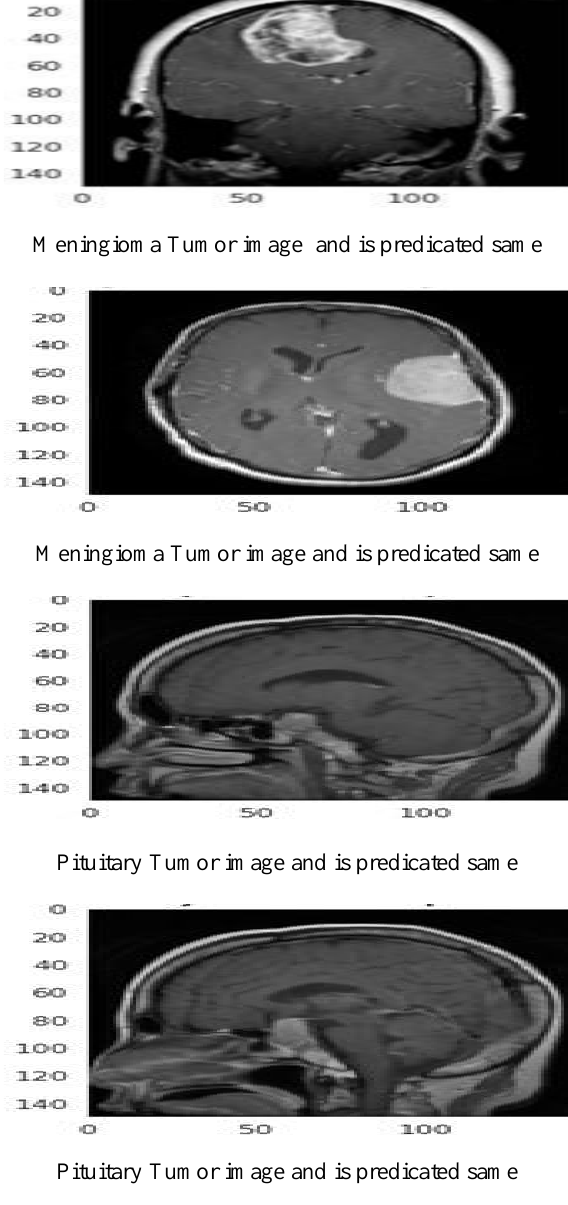
Fig. 7. Visualization of predictions over multiple